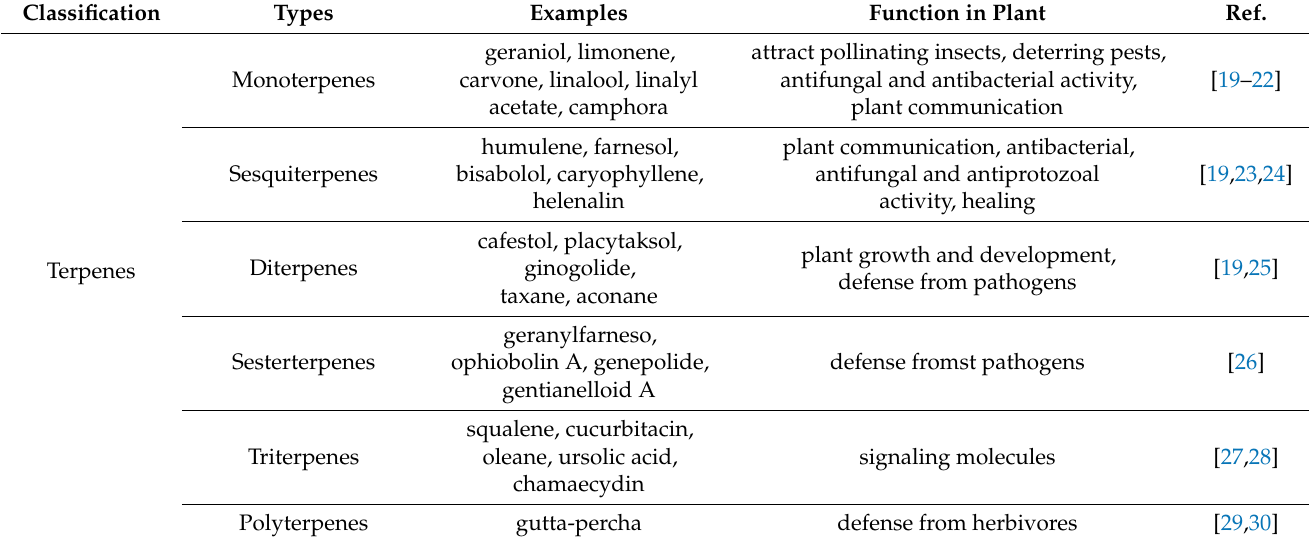
Table 1. Secondary metabolites in